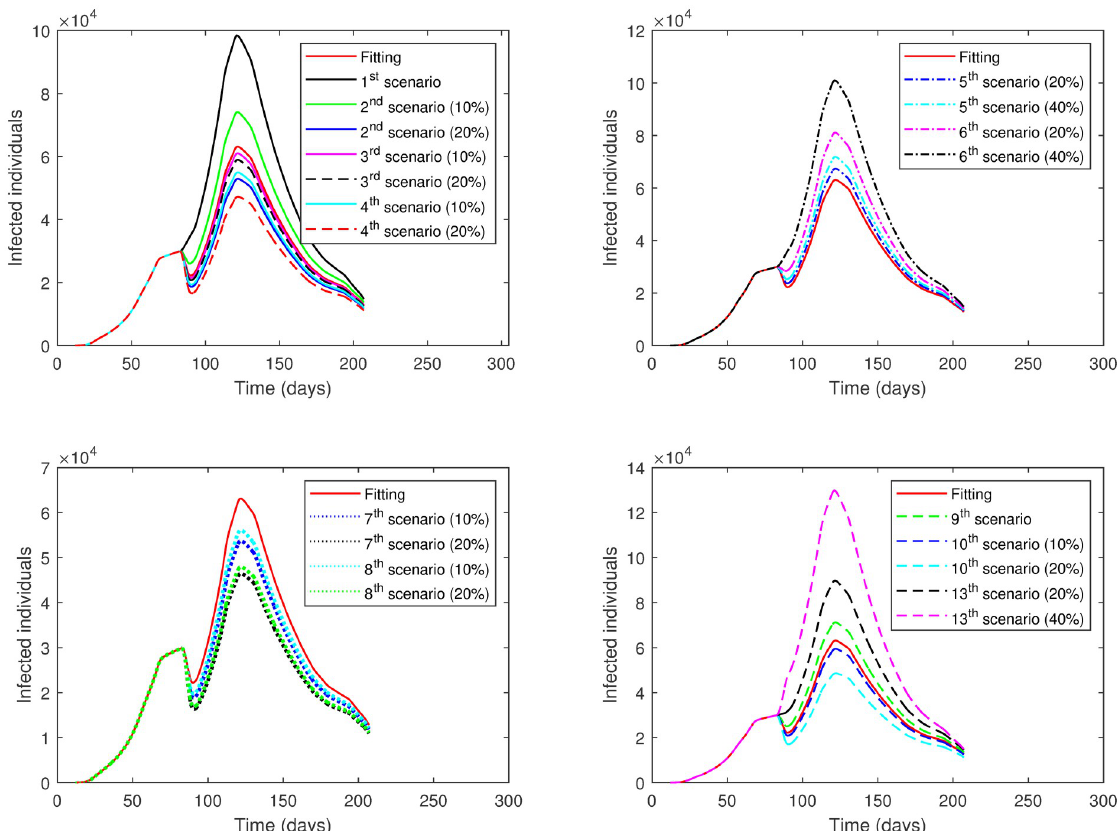
Fig 11. The numerical solution of model (1) for infected compartment vs. time with different scenarios of Phase 5 in the First Case: 1 st scenario, no lockdown is implemented; 2 nd scenario, no lockdown while SD increases; 3 rd scenario, lockdown increases; 4 th scenario, SD increases; 5 th scenario, lockdown decreases; 6 th scenario, SD decreases; 7 th scenario, lockdown and SD increases; 8 th scenario, lockdown decreases and SD increases; 9 th scenario, ρ is the same as in Phase 4; 10 th scenario, ρ is the same as in Phase 4 while SD increases; 13 th scenario, lockdown and SD